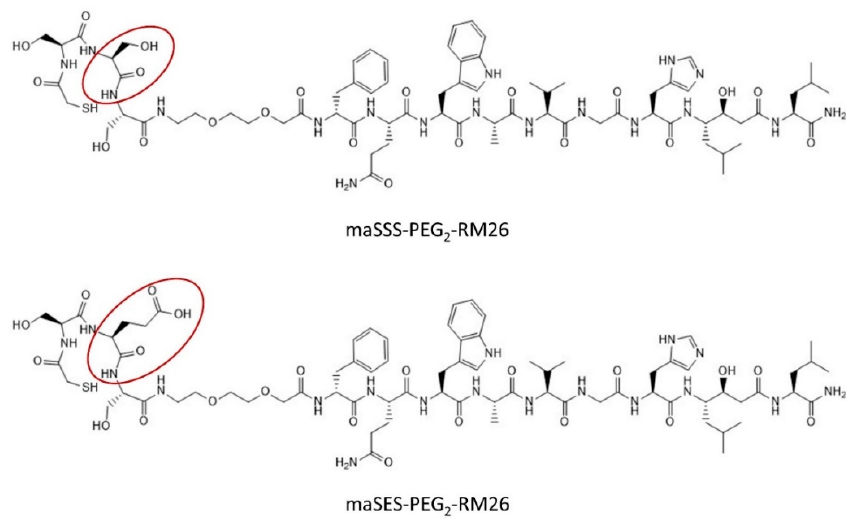
Figure 1. Structures of maSSS-PEG 2 -RM26 and maSES-PEG 2